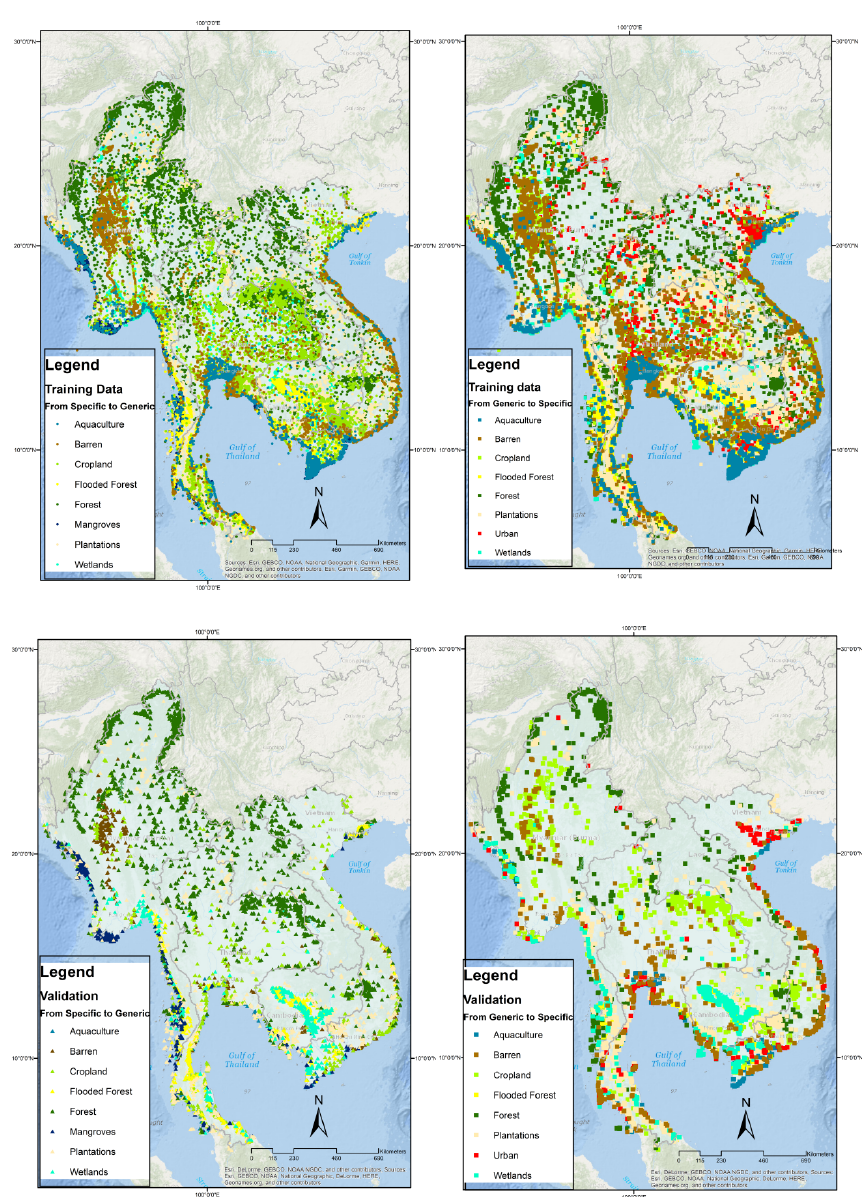
Figure 2. Overview of training ( top ) and validation ( bottom ) samples used in the study. Images on the left show data points in the ‘specific to generic’ category, images on the right ‘generic to specific’. Different colors represent the different